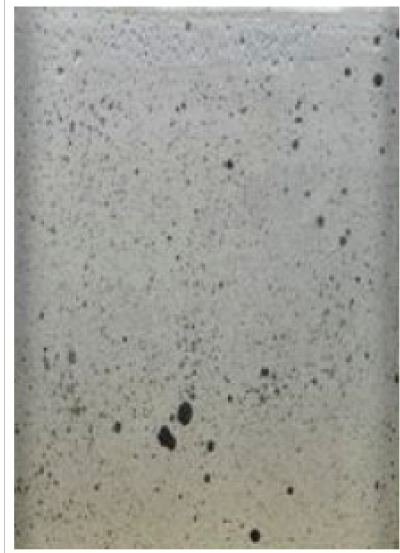
Figure 2. Artificial texture of the surface of the clay specimen.